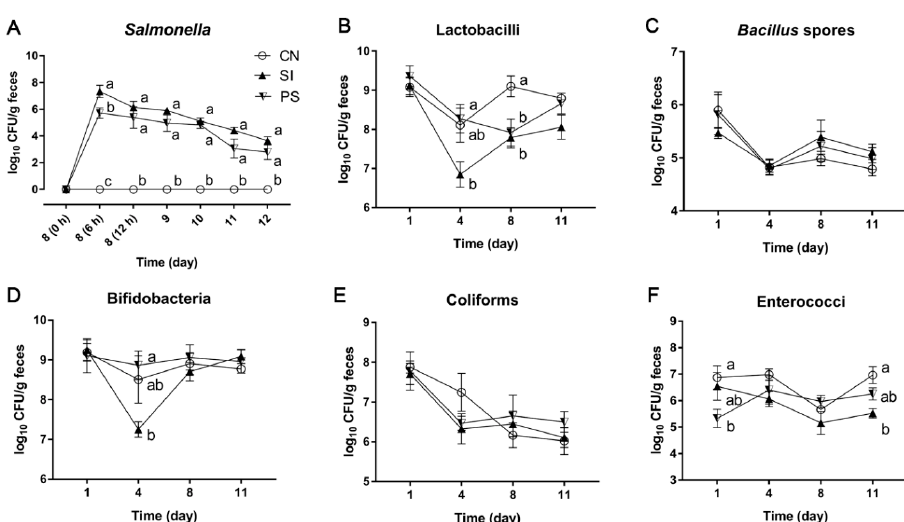
Figure 3. Effects of LBB-mix on the composition of fecal microbiota during S . Infantis infection. ( A ) Salmonella , ( B ) lactobacilli, ( C ) Bacillus spores, ( D ) bifidobacteria, ( E ) coliforms and ( F ) enterococci. Fresh fecal samples from all the piglets were collected on days 1, 4, 8 and 11 after weaning. Results are presented as log 10 CFU/g feces, and all counts were performed in triplicate. Data are presented as the mean ± SEM ( n = 8 per group). Within the same time, mean values with different superscript letters ( a, b ) are significantly different ( p < 0.05).